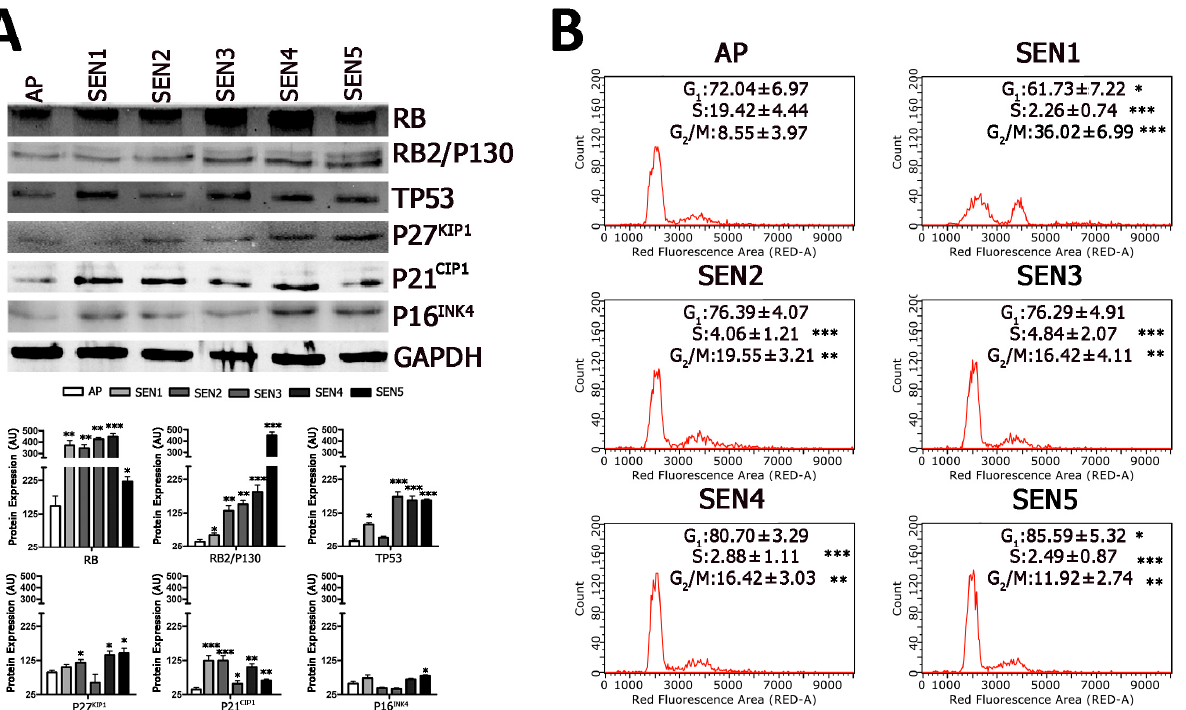
Figure 4. Cell cycle and Western blot analysis of senescent cells. Panels ( A , B ): Cell-cycle profiles and western blot analysis of MSC samples collected at different time points following hydrogen peroxide treatment. The * indicates the statistical difference between AP, chosen as the reference, and the other time points (* p < 0.05, ** p < 0.01, *** p < 0.001). In panel ( A ), the graphs show the quantification of western blot bands that was performed by using GAPDH as the loading control.